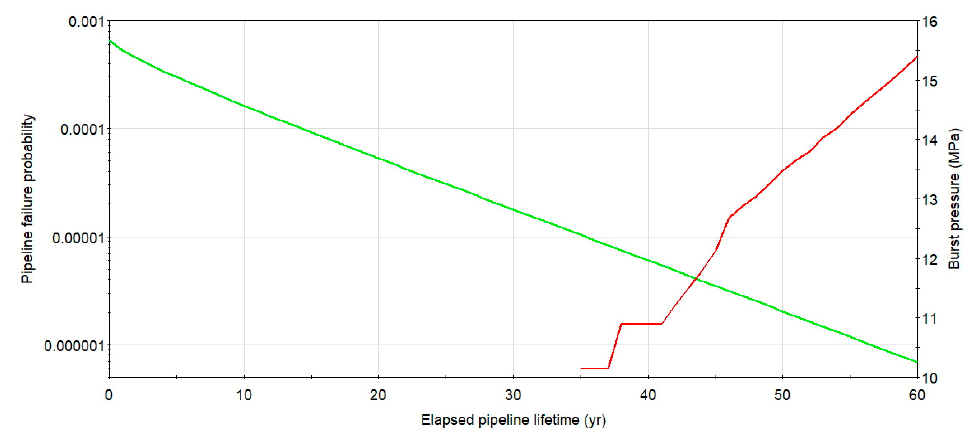
Figure 7. Change of rupture pressure and failure probability with time for X52 DN 700 MOP = 5.5 MPa pipeline with the longest detected defect and the initial depth of 12%. Source: Author’s analysis. The plot of the burst pressure and a probability of rupture logarithmic graph for clus- ter 1 with the combined length of l nm = 27.5 mm and the maximum depth of 22% of the wall thickness as a function of pipeline service time for the considered case is presented